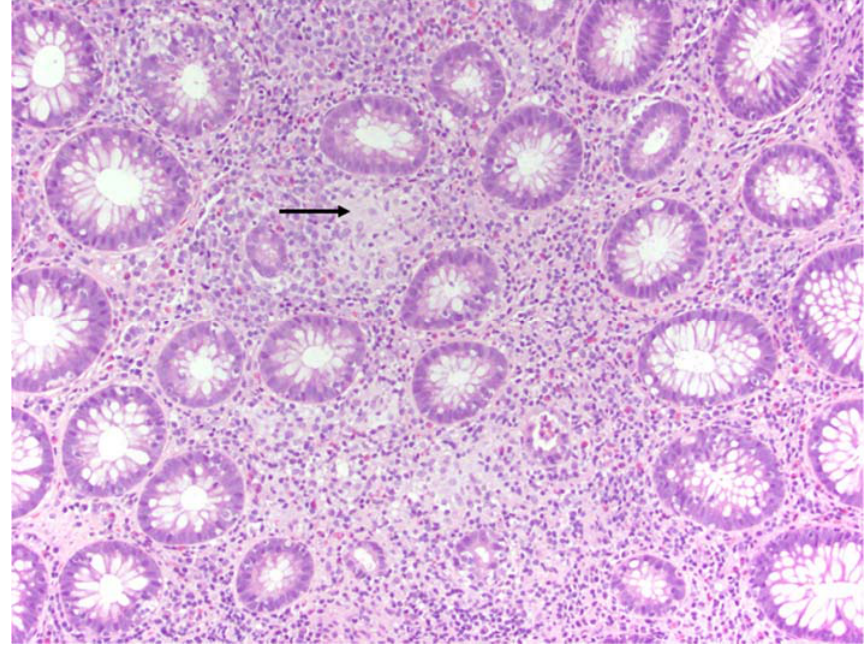
Figure 2. Histopathology showing cryptitis and noncaseating granuloma (arrow) in rectal mucosa (H&E, 400×).